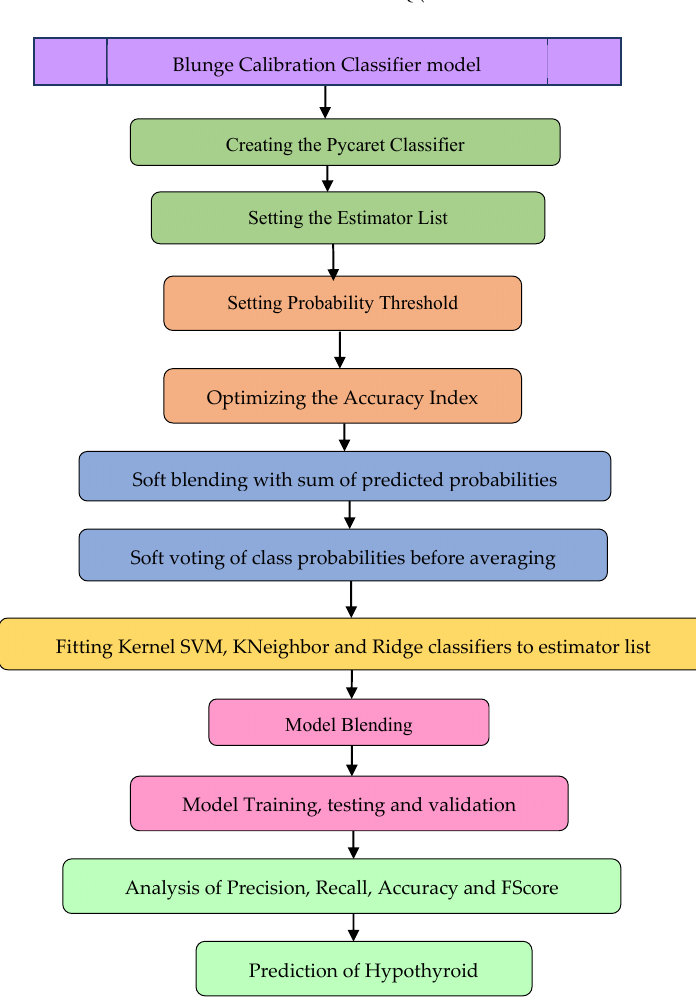
Figure 3. Blunge calibration classifier model workflow.